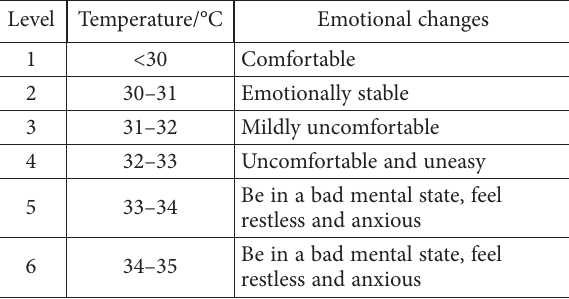
Table 1. Grading of influence of high temperature on distress Level Temperature/°C